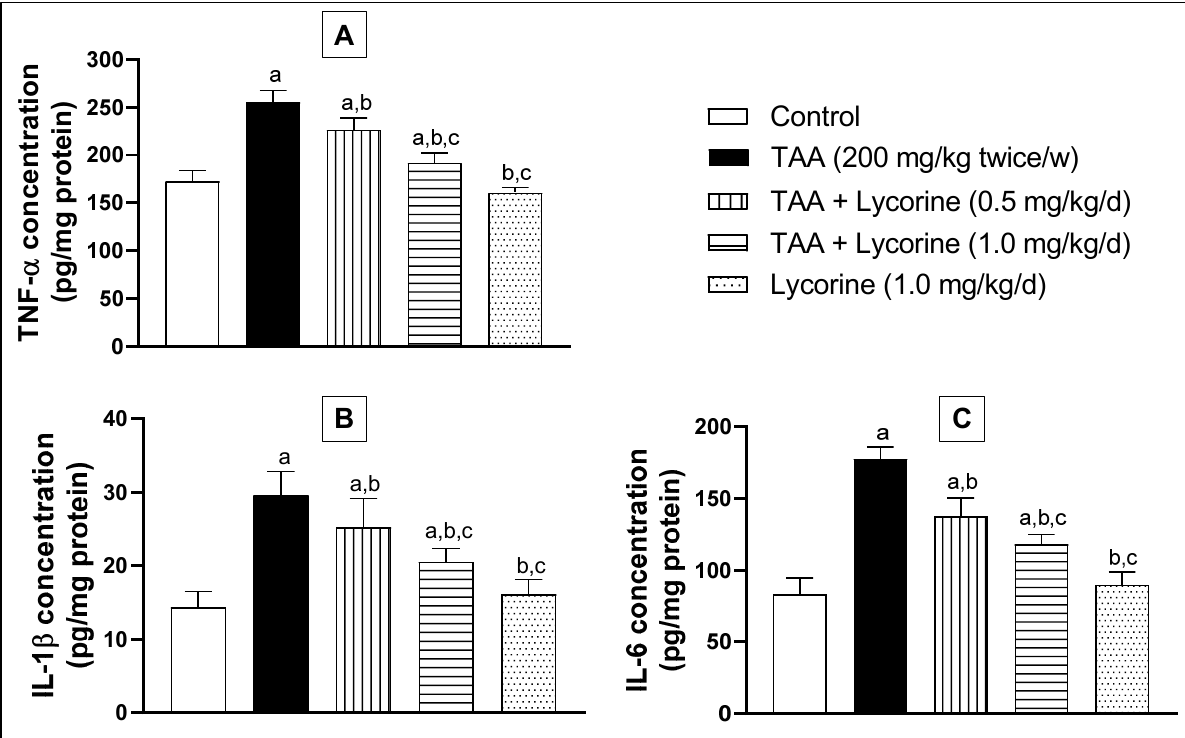
Figure 6. Effect of lycorine on the homogenate concentration of ( A ) TNF- α , ( B ) IL-1 β , and ( C ) IL-6 in a rat model of TAA-induced liver fibrosis. Data are presented as mean ± S.D. ( n = 6). Statistical analysis was carried out by one-way ANOVA followed by Tukey’s post- hoc test. (a) Statistical significance from the corresponding control at p < 0.05. (b) Statistical significance from the TAA-challenged group at p < 0.05. (c) Statistical significance from the TAA + lycorine 0.5 mg/kg/d group at p < 0.05. TAA: thioacetamide; TNF- α : tumor necrosis factor-alpha; IL-1 β : interleukin-1beta; IL-6: